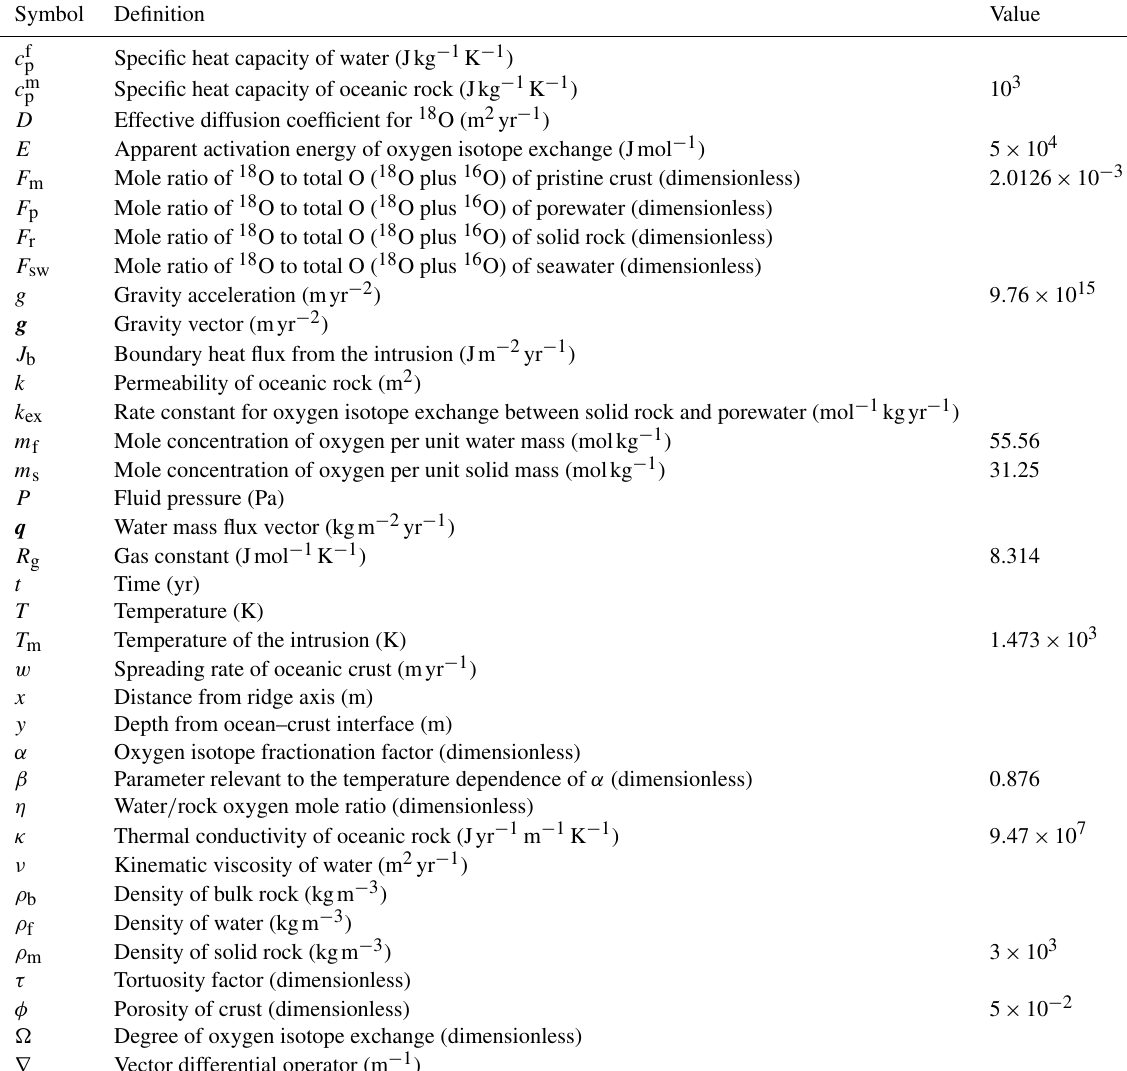
Table 1. Symbols and their definitions and